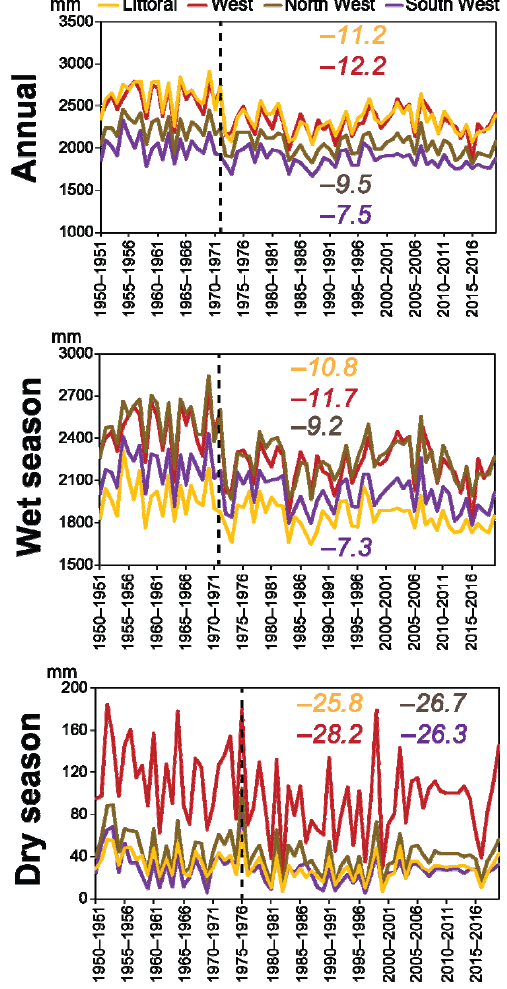
Figure 5. Temporal variation of annual and seasonal rainfall for the western regions of the country (Littoral, West, North-West, and South-West), according to the Pettitt test. The rupture years are indicated by the vertical dashed lines. On their right sides appear the corresponding rates of change. The ruptures in black are those which are identical to several regions.